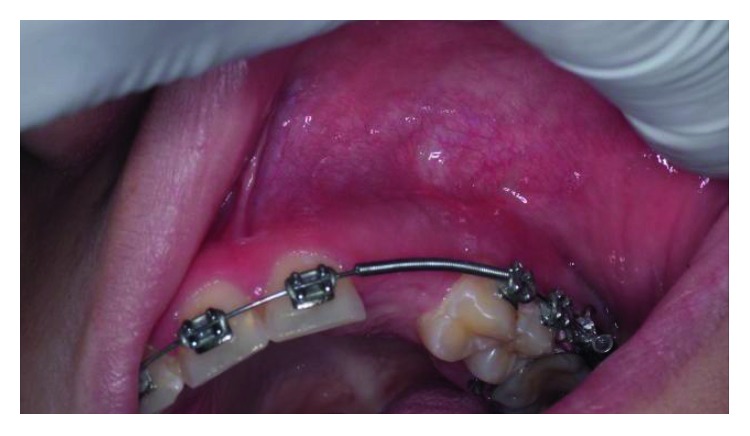
Two weeks postop.